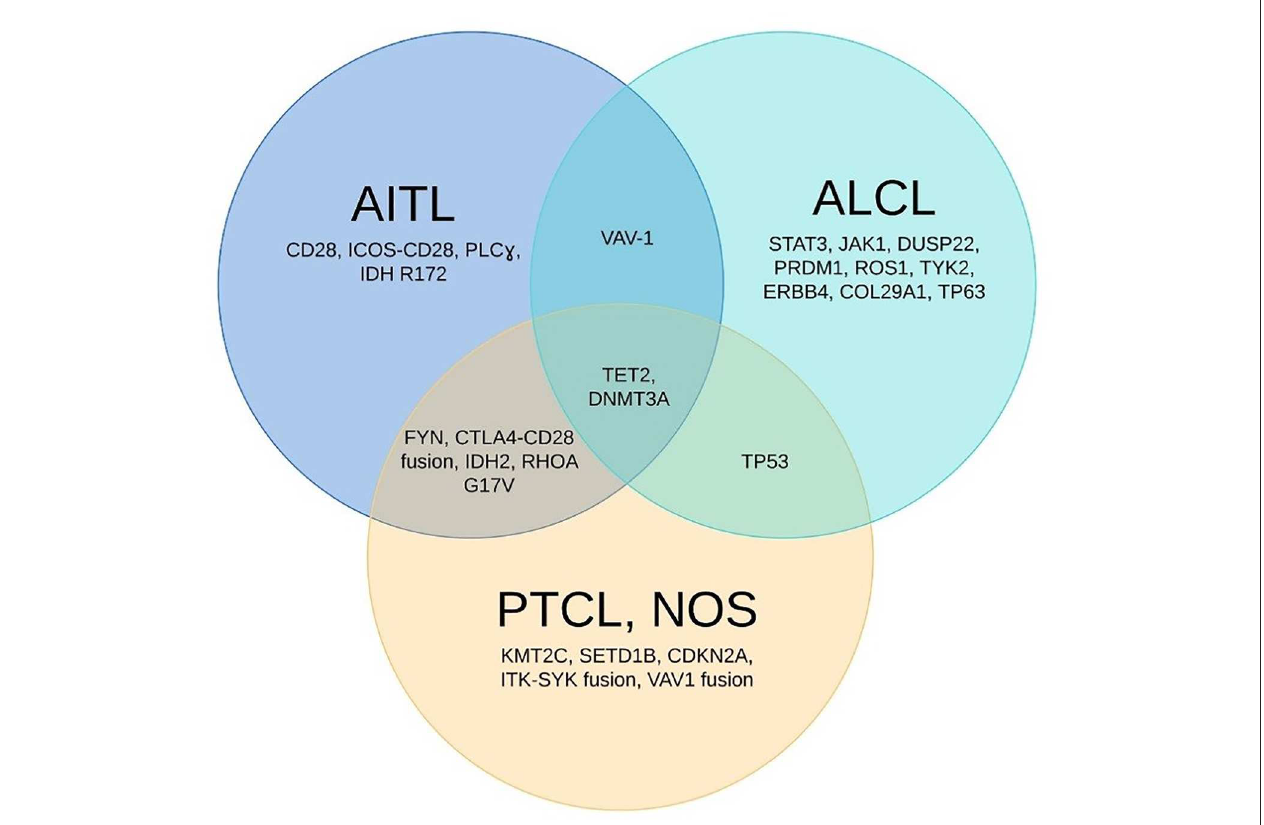
FIGURE 1 | Unique and shared mutations identified in the 3 most common types of PTCL. The Venn diagram above showed the most frequently encountered genomic abnormalities in 3 most common types of peripheral T-cell lymphoma: angioimmunoblastic T-cell lymphoma (AITL), anaplastic large cell lymphoma (ALCL), and peripheral T-cell lymphoma-not otherwise specified (PTCL-NOS). TET2 and DNMT3A mutations are seen in all 3 major